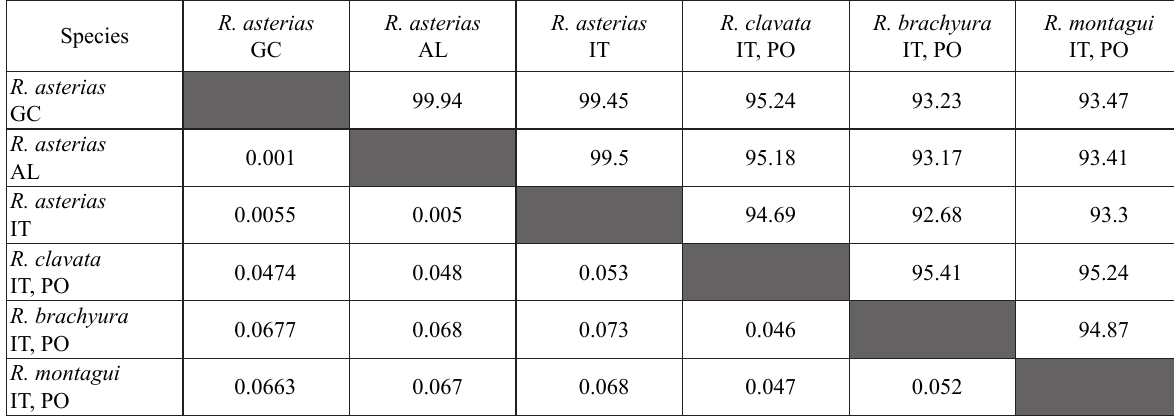
Mean value of genetic distances ( p distance, lower triangular matrix comparisons) and percentage of identity (upper triangular matrix comparisons) for cytochrome c oxidase subunit I (COI) fragment from Raja species, below and above the diagonal,